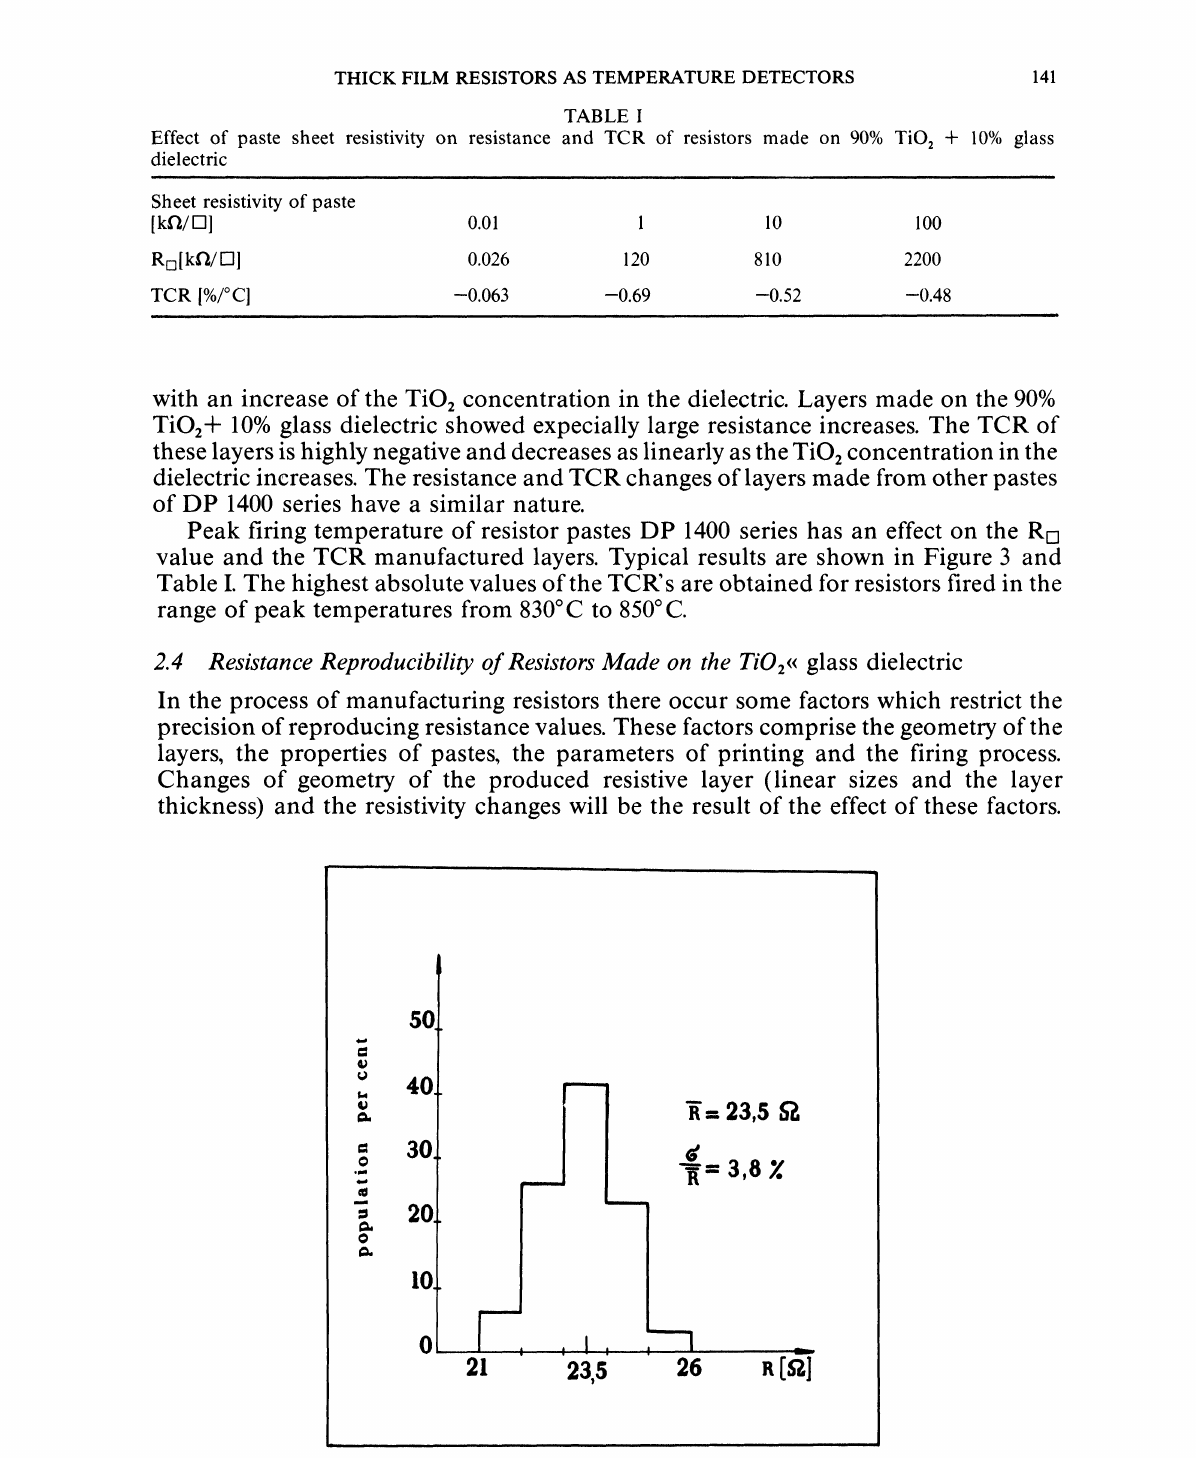
FIGURE 4 Resistance histogram of resistors made of 10 /I-’1 paste on 70% TiO + 30% glass dielectric. Firing temperature 830